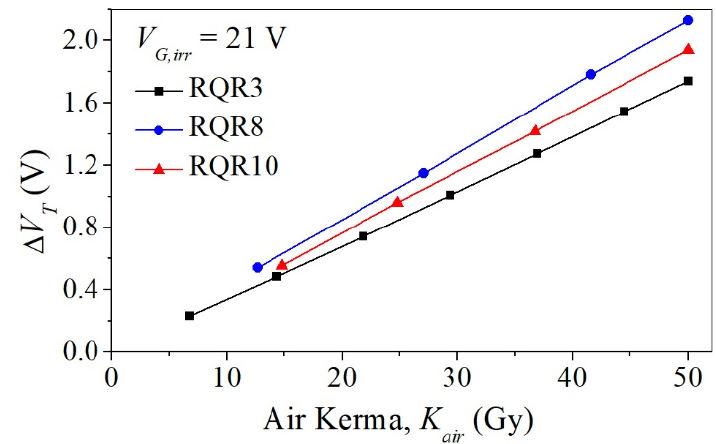
Figure 2. Threshold voltage shift versus air kerma. Table 2. The sensitivity, S , of irradiated VDMOSFETs.